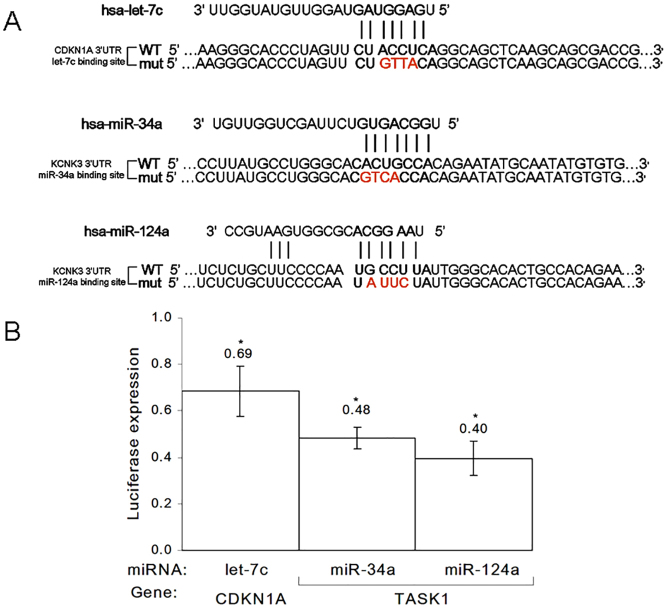

Luciferase reporter activity indicates direct binding and regulation of miRNAs.Luciferase reporter activity indicates direct binding and regulation of miRNAs. (A) Sequences of Renilla or firefly luciferase under regulation of CDKN1A or KCNK3 3′UTRs that were used for transient reporter assay experiments. Wild-type (WT) and mutant (mut) alleles for each of the three miRNA-binding sites are presented. The miRNA seed region and complimentary 3′UTR sequence are marked in bold. Mutagenized nucleotides are in red and bold. (B) Luciferase activity at 48 hours after co-transfection of different miRNA combinations with Renilla and firefly luciferase constructs under regulation of the CDKN1A or TASK1 3′UTR. The data presented are the relative levels of Renilla luciferase expression standardized to those of firefly luciferase. Data show the mean±s.e.m. (n = 3); *P<0.05 (paired Student's t-test).